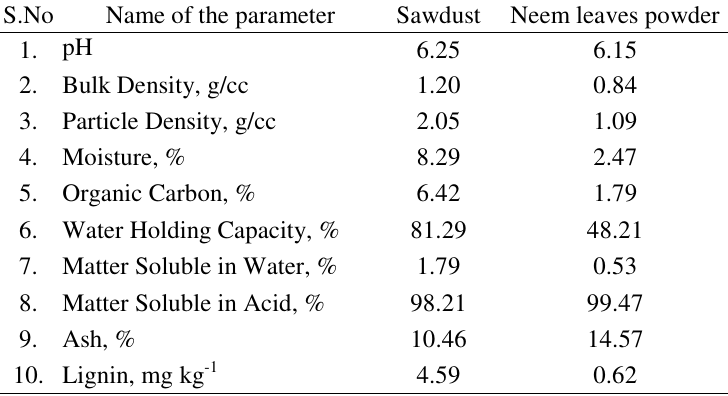
Table 1. Characteristics of sawdust and neem leaves